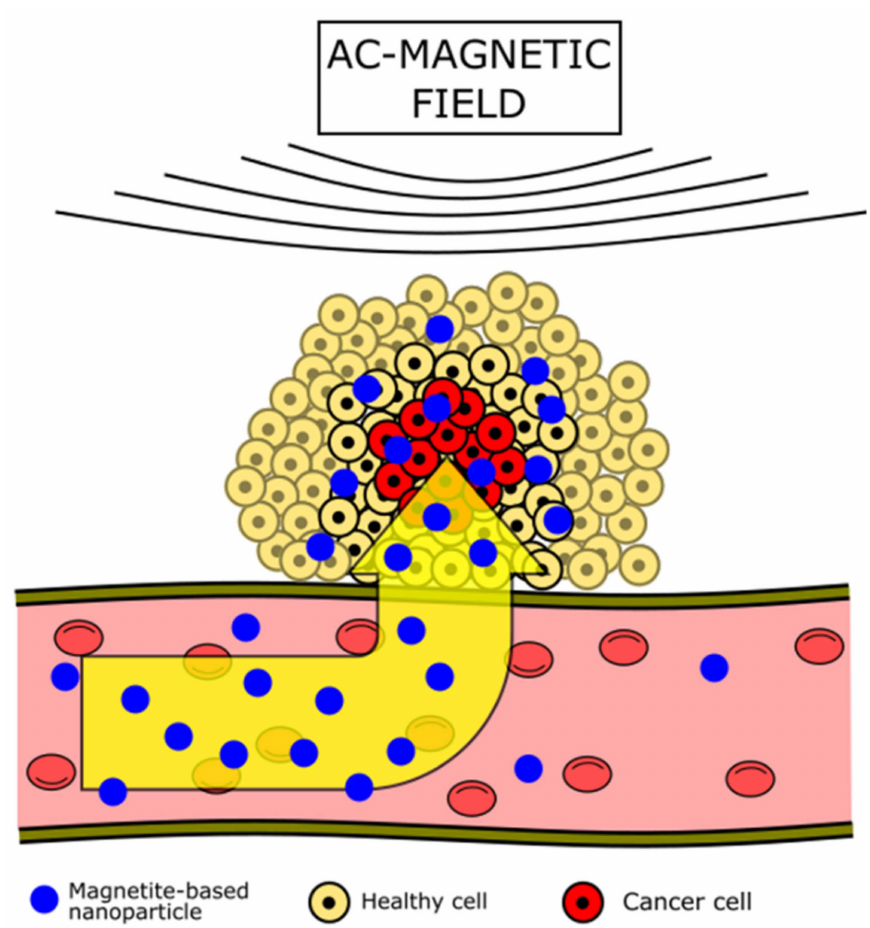
Figure 2. Magnetite-based drug delivery occurs under the influence of an external AC magnetic field. Nanoparticles are pulled from a blood vessel to a pathological site and migrate toward the source of altering magnetic field. The pulled-out nanoparticles are concentrated in a tumorous site with minimal interaction with healthy cells. Then, release of the therapeutics load